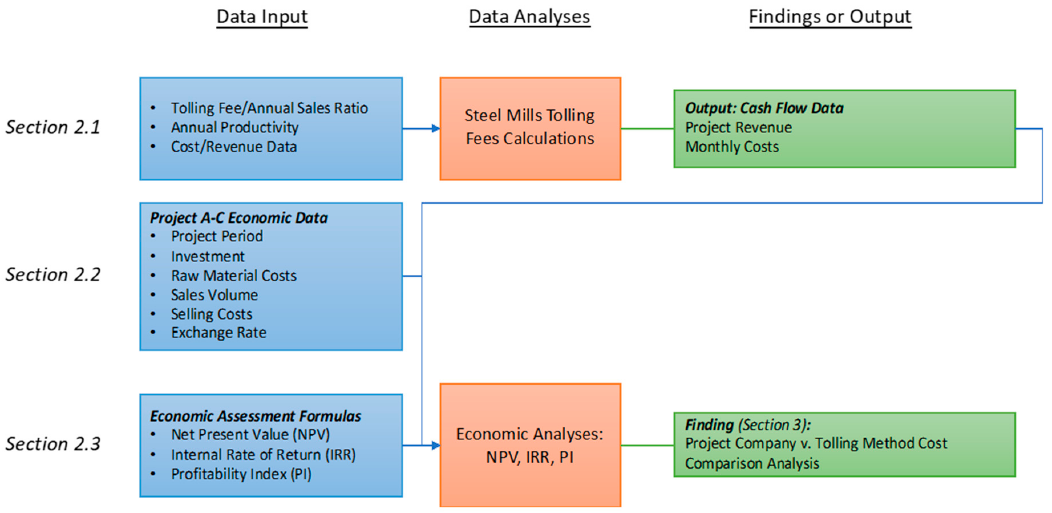
Figure 3. Research